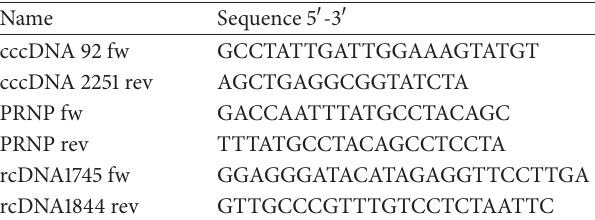
Table 1: Primers for